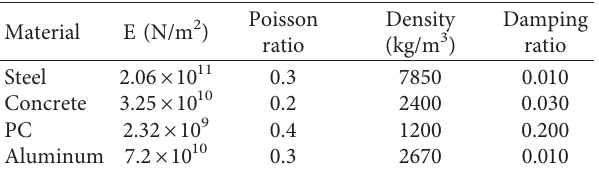
Figure 7: FE model of the SESB and typical modal vibration shape: (a) finite element model; (b) the first transverse bending (4.00 Hz); (c) the first vertical bending (5.45 Hz). Table 1: Material properties of SESB.